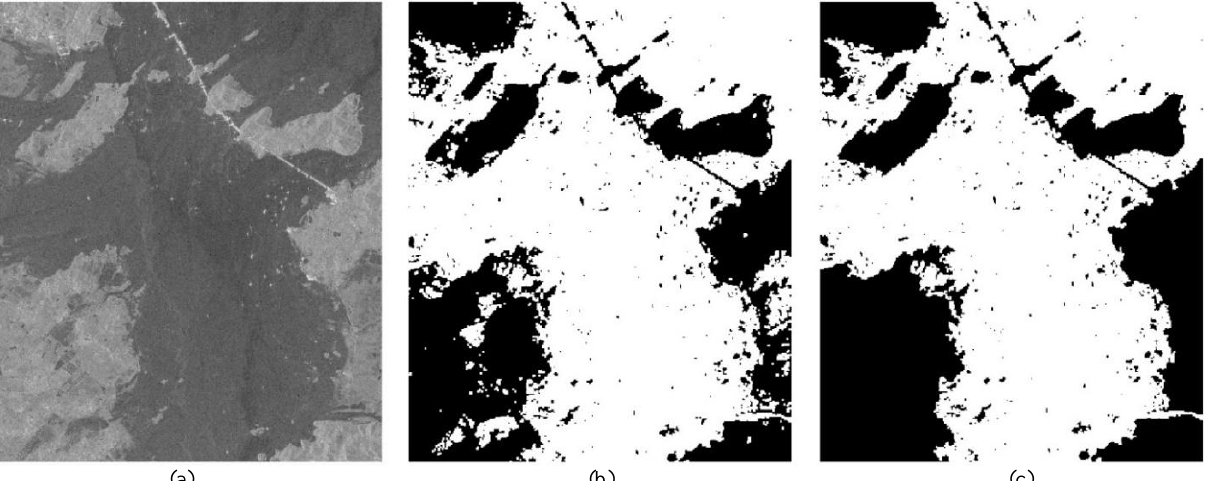
Fig.6 Land and sea separation. (a)SAR backscattering coefficient image, (b) water pixels extraction results, (c) land and sea separation results.